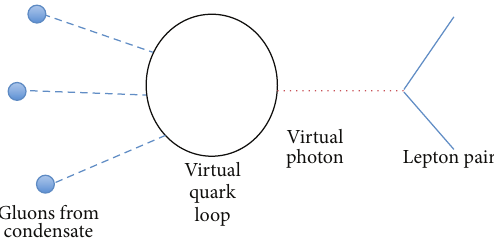
Figure 2: Three gluons from the condensate annihilate into a virtual quark loop, that subsequently decays into a virtual photon and then into a dilepton.